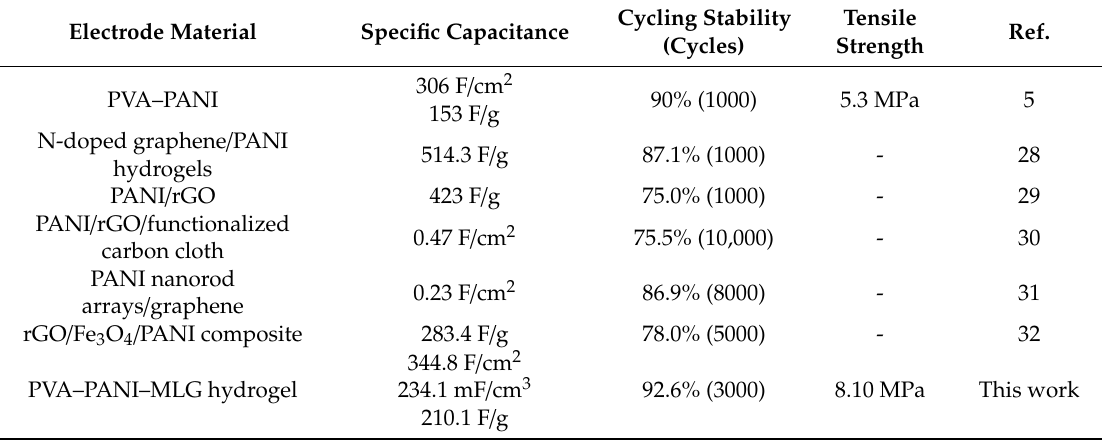
Table 6. Performance comparison of state-of-art supercapacitors based on PANI and